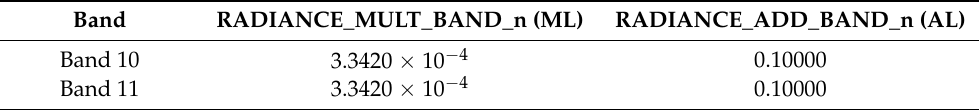
Table 5. Radiation correction of Landsat 8 TIRS.